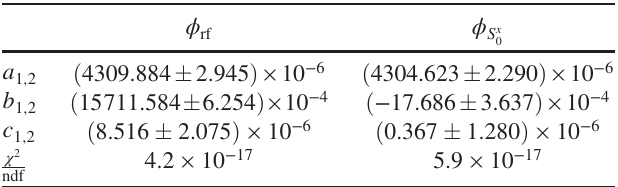
TABLE IV. Summary of parameters obtained (for K ¼ − 1 ) via fitting the oscillatory patterns of the initial slopes shown in Fig. 11 as function of ϕ and ϕ , still including the factor S x 0 rf ¼ 10 3 . For the other harmonics ( K ¼ 0 , 1, and (cid:4) 2 ), within f ampl the given uncertainties, the same values are